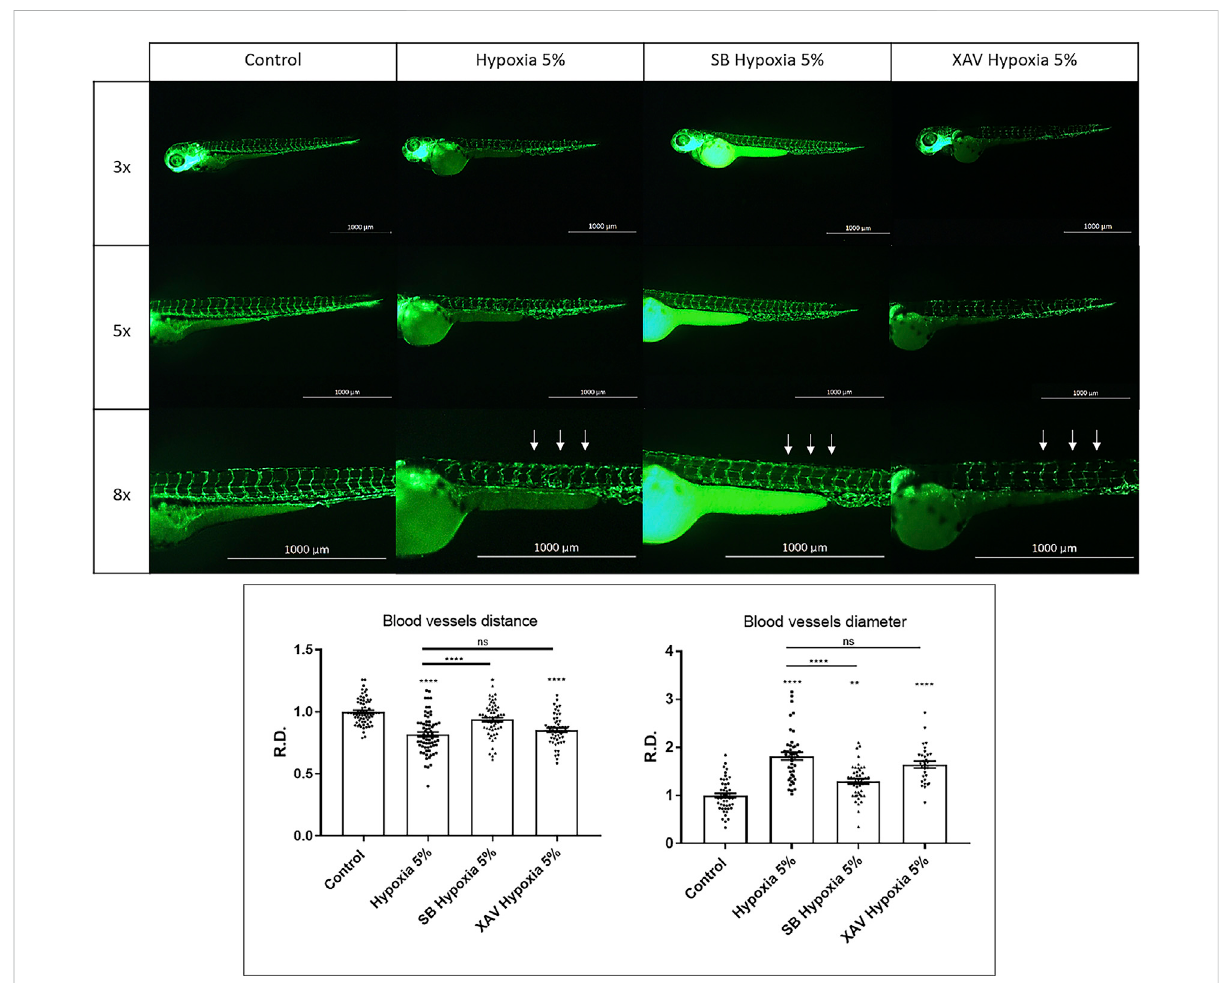
FIGURE 7 Wnt/ β -catenin upregulation can rescue hypoxia-induced vascular defects. Upregulation of Wnt/ β -catenin signalling using 40 µM SB216763 (SB)canrescuethevascularorganization(reciprocaldistanceandvesseldiameter)inhypoxia-treatedembryos. Conversely,downregulationofWnt/ β -catenin signalling using 5 µM XAV939 leads to a worsened phenotype. Intersegmental vessels (arrows) were inspected in 3 dpf embryos, after 2- days longincubation innormoxia(control)or5%hypoxia,exploitingtheendothelial-speci fi ctransgene Tg( fl i1:EGFP) y1 .All pictures displaytrunk regions in lateral view, anterior to the left. Sample size: n = 15; ns = not signi fi cant; * = p < 0.05; ** = p < 0.01; **** = p < 0.0001; R.D. = Relative Distance. Test: One-way ANOVA followed by Tukey ’ s